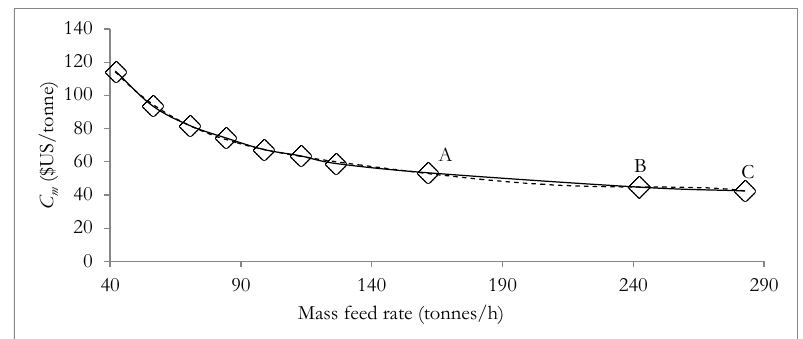
Figure 6. Variation of the unit production cost with the mass feed rates. Points A, B and C represent mass feed rates of TMPS that are 192%, 288% and 336% (all greater than 150%) of the base case TMPS mass feed rate of 84.2 tonnes/h.